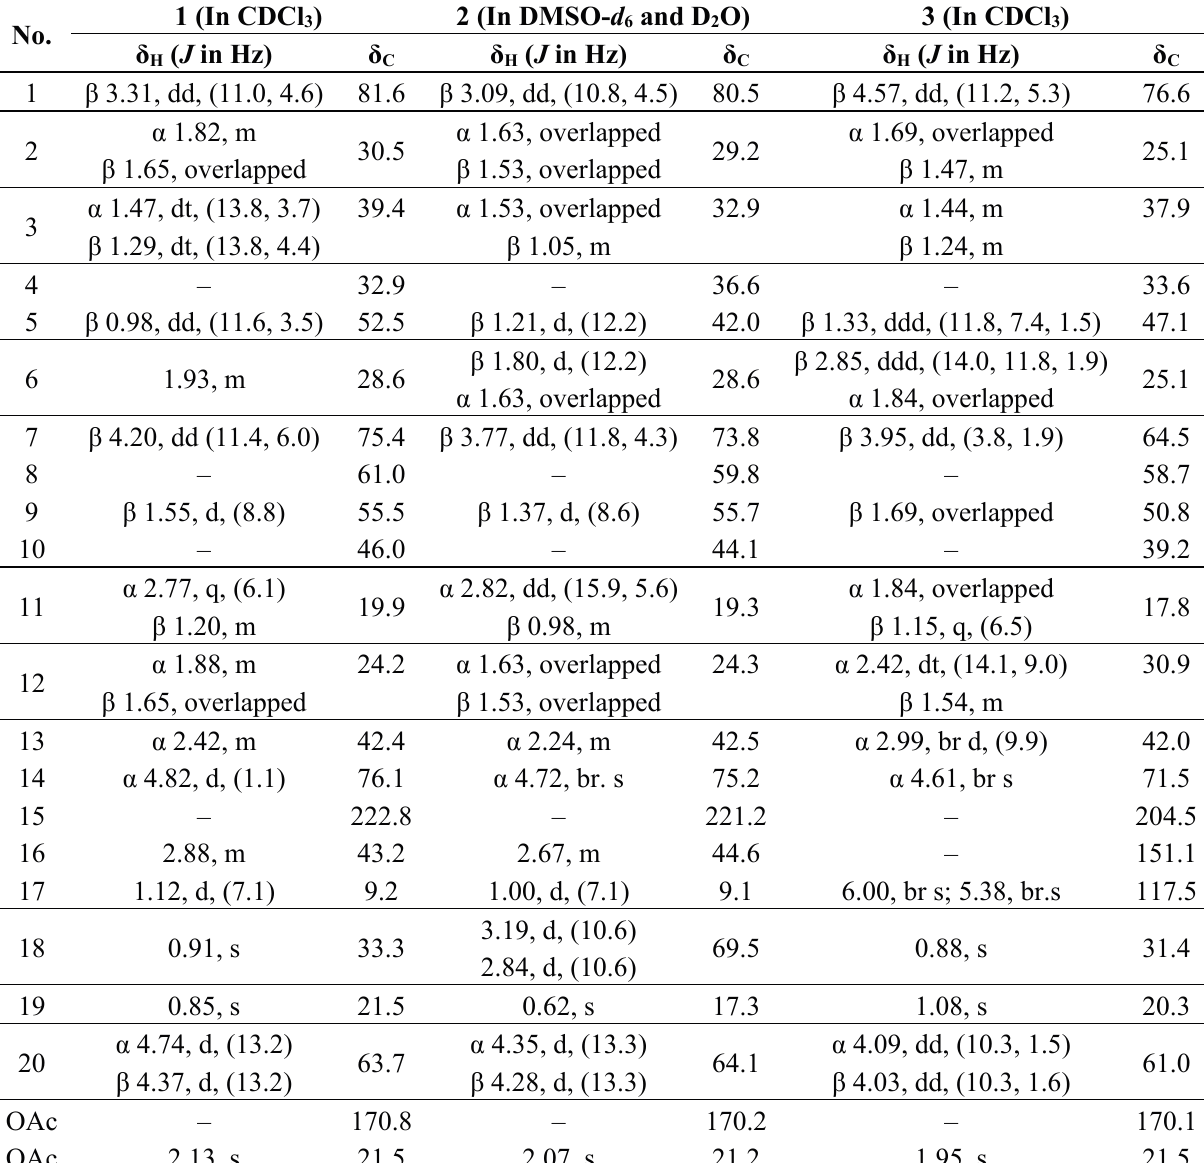
Table 1. 1 H- and 13 C-NMR data of compounds 1 – 3 (500 and 125 MHz δ in